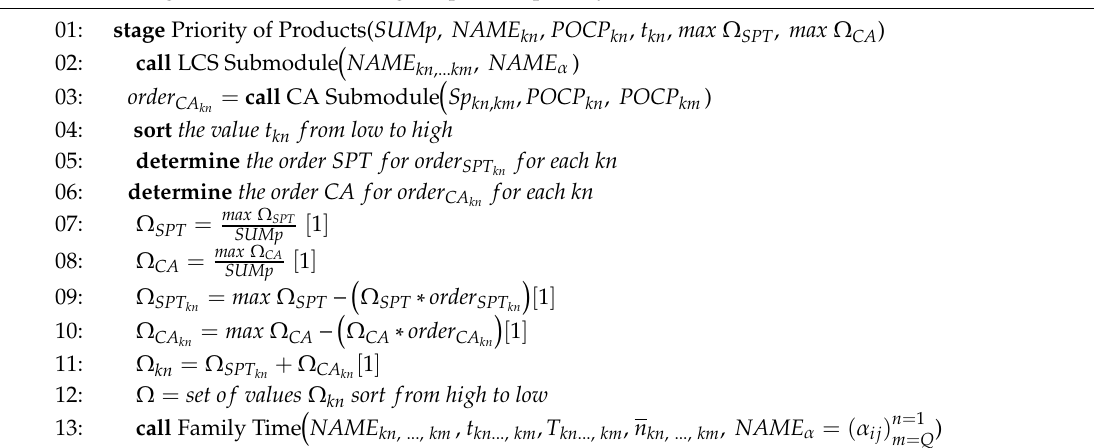
Algorithm 3 Algorithm for determining the product